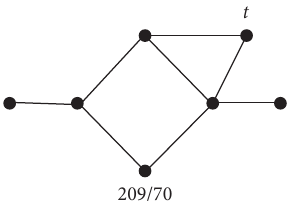
Figure 8: The graphs related to Subcase 2.2 of Theorems 3 and 4.